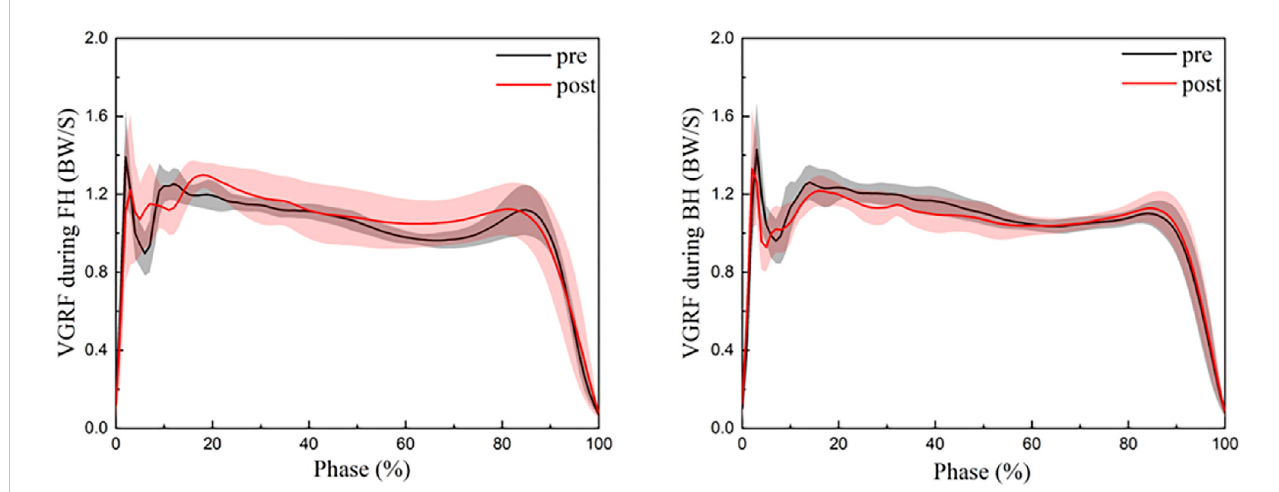
FIGURE 4 Change of the vertical GRF during the strike phase in the FH and BH. FH, forehand lunge; BH, backhand lunge; pre, pre-fatigue, post, post-fatigue.